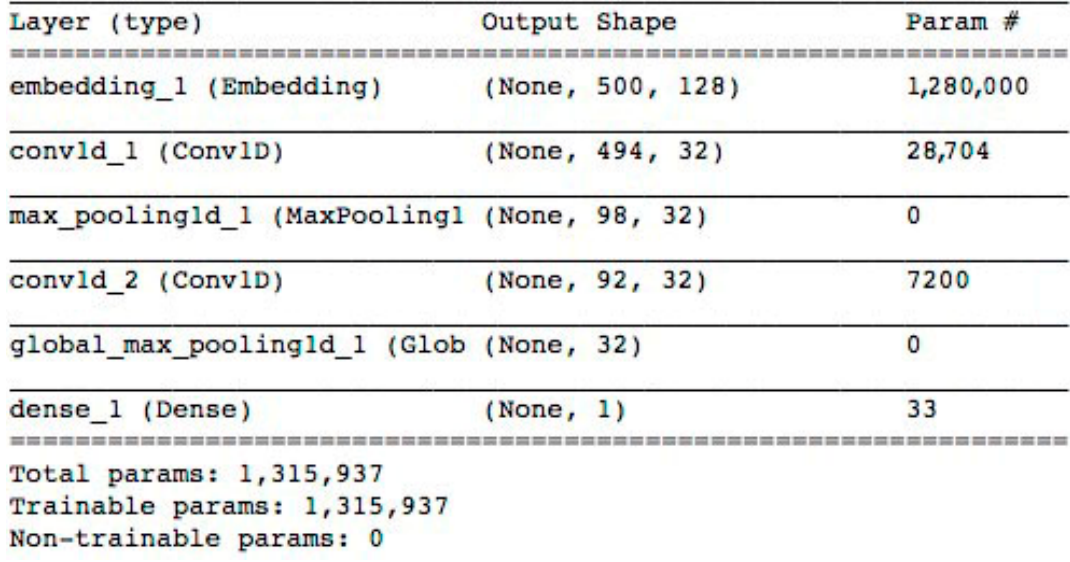
Figure 6. Structure diagram of convolutional neural network.